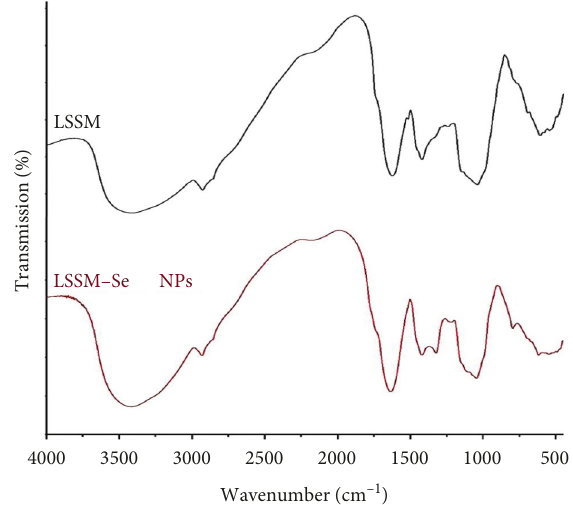
Figure 2: FTIR spectra for LSSM and LSSM-Se NPs.